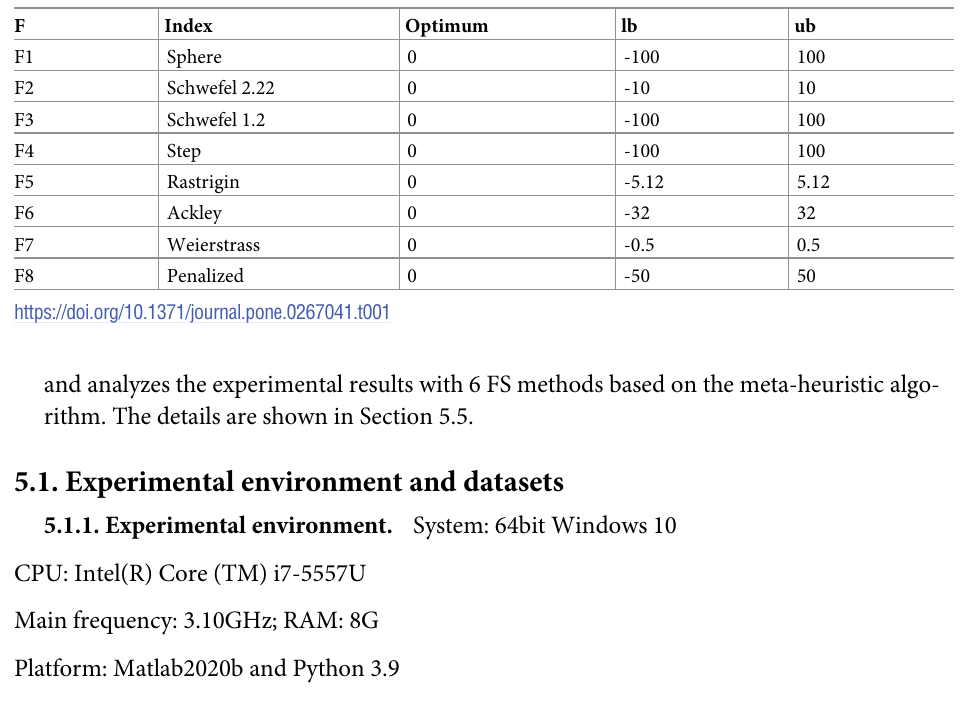
Table 1. Benchmark functions used and their details.